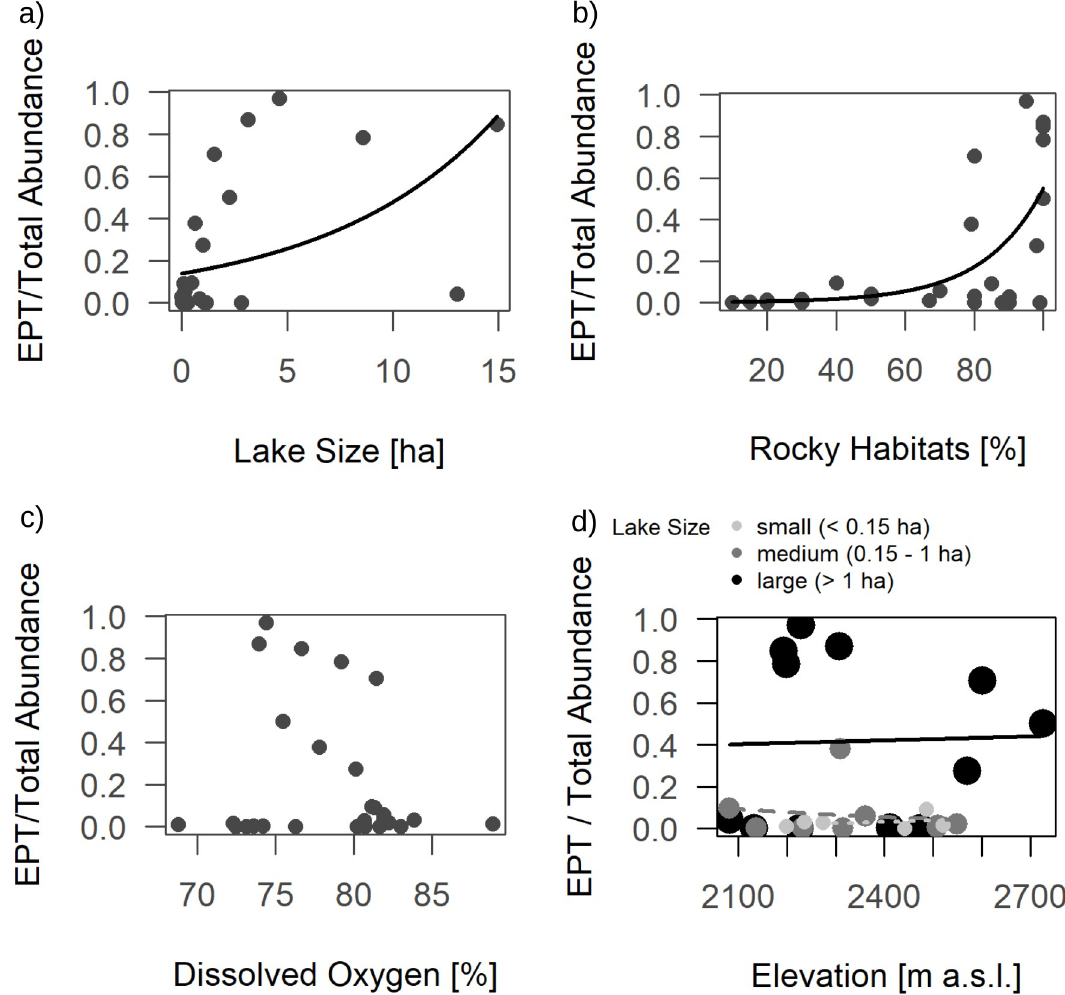
Fig 4. Effect of the ratio of EPT (Ephemeroptera, Plecoptera, Trichoptera) abundance by total abundance in alpine lakes and a) lake size; b) proportion of rocky habitats (sum of small rocks and sheer rock faces/boulders); c) dissolved oxygen and d) the interaction of elevation and lake size, where lake size is visualized by different shades of grey and size of the symbols. Regression lines from generalized linear regression with quasipoisson distributions and log-links are shown for significant effects (Table